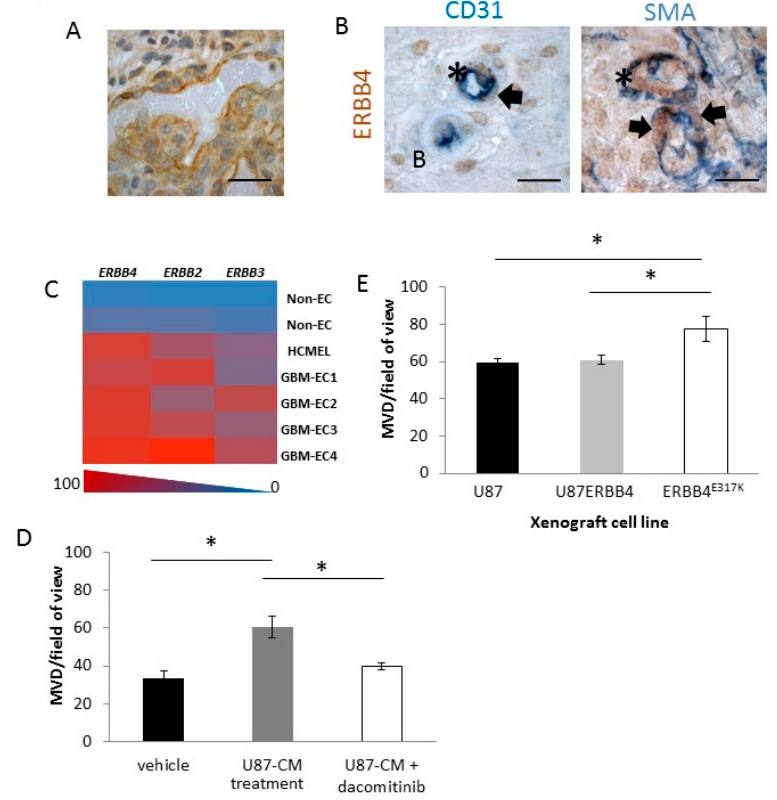
Figure 6. Angiogenic role of ERBB4. ( A , B ) p-ERBB4 expression on the vasculature of the GBM glomeruloid structure identified with DAB (brown), with nuclei counterstained with hematoxylin ( A ). IHC double stains demonstrated p-ERBB4 (brown) expression on endothelial cells (CD31, blue) and on pericytes (SMA, blue) in GBM patient samples ( B ). All IHC was performed on four biological replicates. Arrows point to pericytes, and asterisks identify endothelial cells. Scale bars, 25 µm. ( C ) Heat map of ERBB4 , ERBB3 and ERBB2 mRNA expression of endothelial cells isolated from four samples of GBM (GBM-EC), one normal brain endothelial cell line (HCMEC) and two non-endothelial cell lines (non-EC), as measured by RT-qPCR. RT-qPCR was performed on triplicate samples. ( D , E ) MVD counts from subcutaneous agar plugs containing U87MG conditioned medium (U87-CM) following treatment with dacomitinib ( D ); representative images are shown in Figure S9A. MVD counts for U87MG, U87ERBB4 and ERBB4 E317K xenografts ( E ); representative images are shown in Figure S9B. Bars indicate mean values ± SEM ( n = 4). Asterisks indicate bars that are significantly different from each other ( p < 0.05, one-way ANOVA).